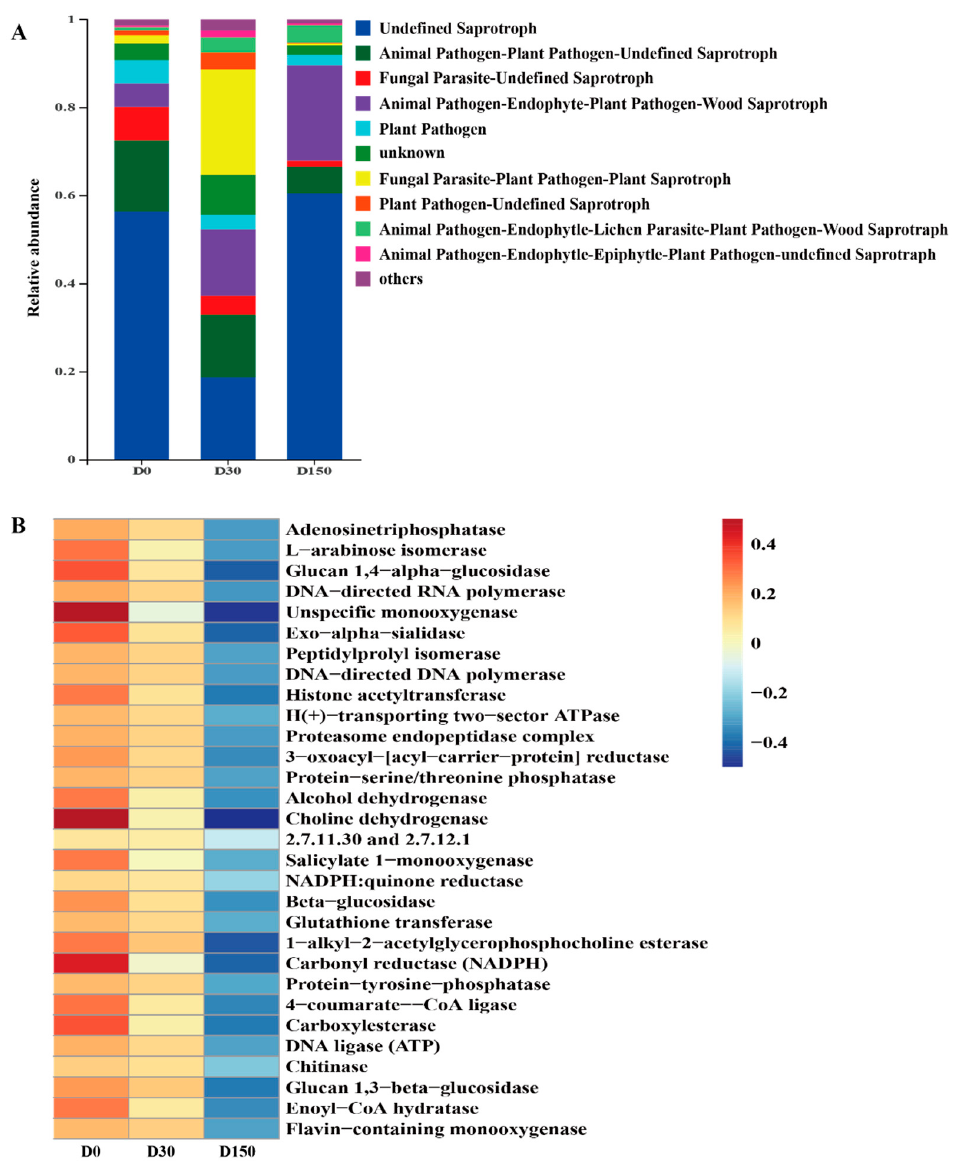
Figure 5. ITS gene-predicted fungal functional profiles during storage analyzed by FUNGuild and PICRUSt (n = 6). ( A ) Variations in the composition of fungal functional groups inferred by FUNGuild. ( B ) Level 3 KEGG ortholog functional predictions of the relative abundances of the top 30 enzymes.